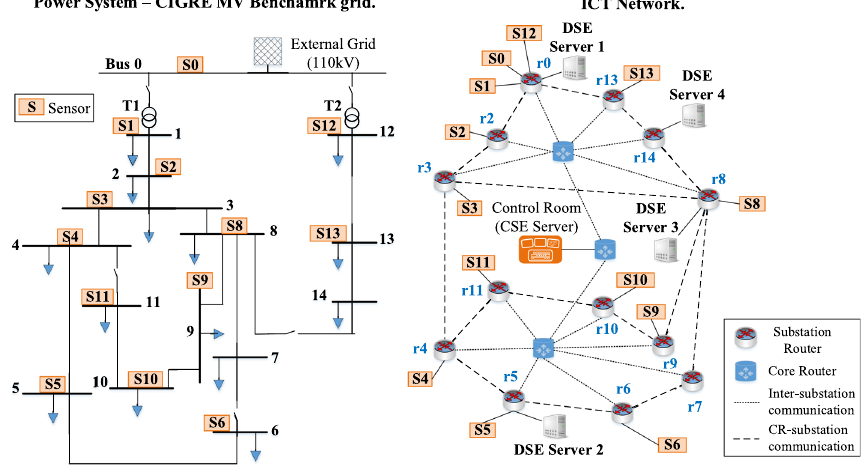
Fig. 1 Simulated model cyber-physical energy